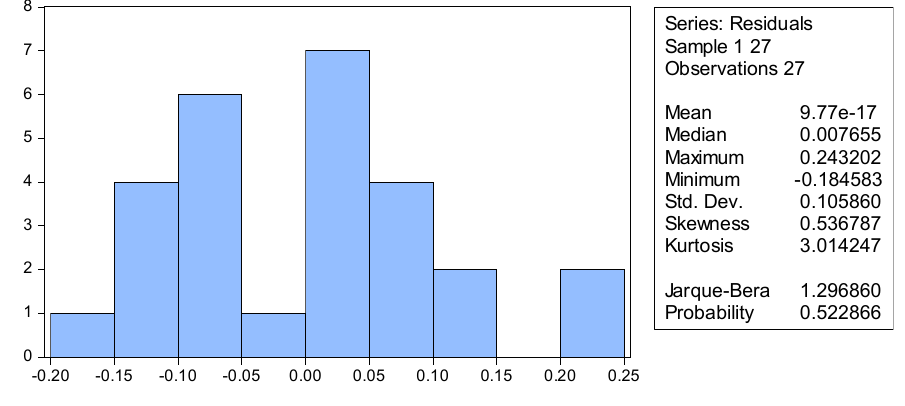
Fig. 1. The results of Jarque–Bera